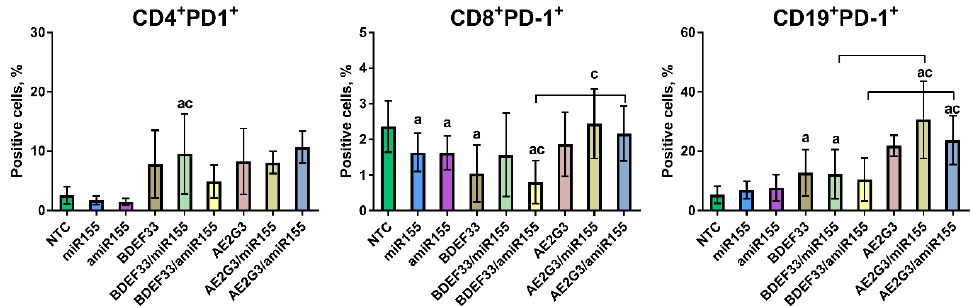
Figure 5. Evaluation of expression of PD-1 on CD4 + and CD8 + T-lymphocytes, CD19 + B-lymphocytes after 72 h of treatment by dendriplexes or their complexes. Mann–Whitney test was used. Letters mark significant differences ( p < 0.05): “a”—in comparison with NTC, “b”— in comparison with treatment by free dendrimer, “c”— in comparison with treatment by free miR, bars mark the differ- ence between similar groups.